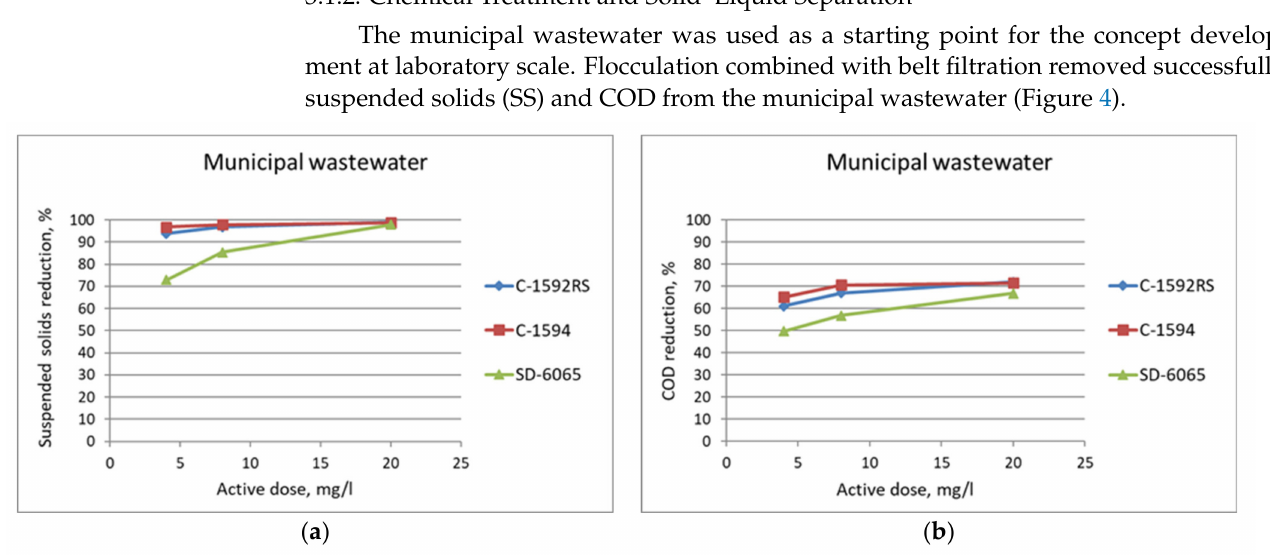
Figure 4. Reduction in suspended solids ( a ) and COD ( b ) using emulsion flocculants for the municipal wastewater at laboratory scale tests.